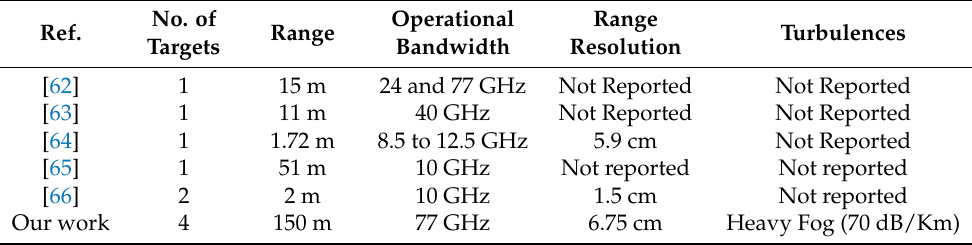
Table 4. Performance Comparison with Recent Works.